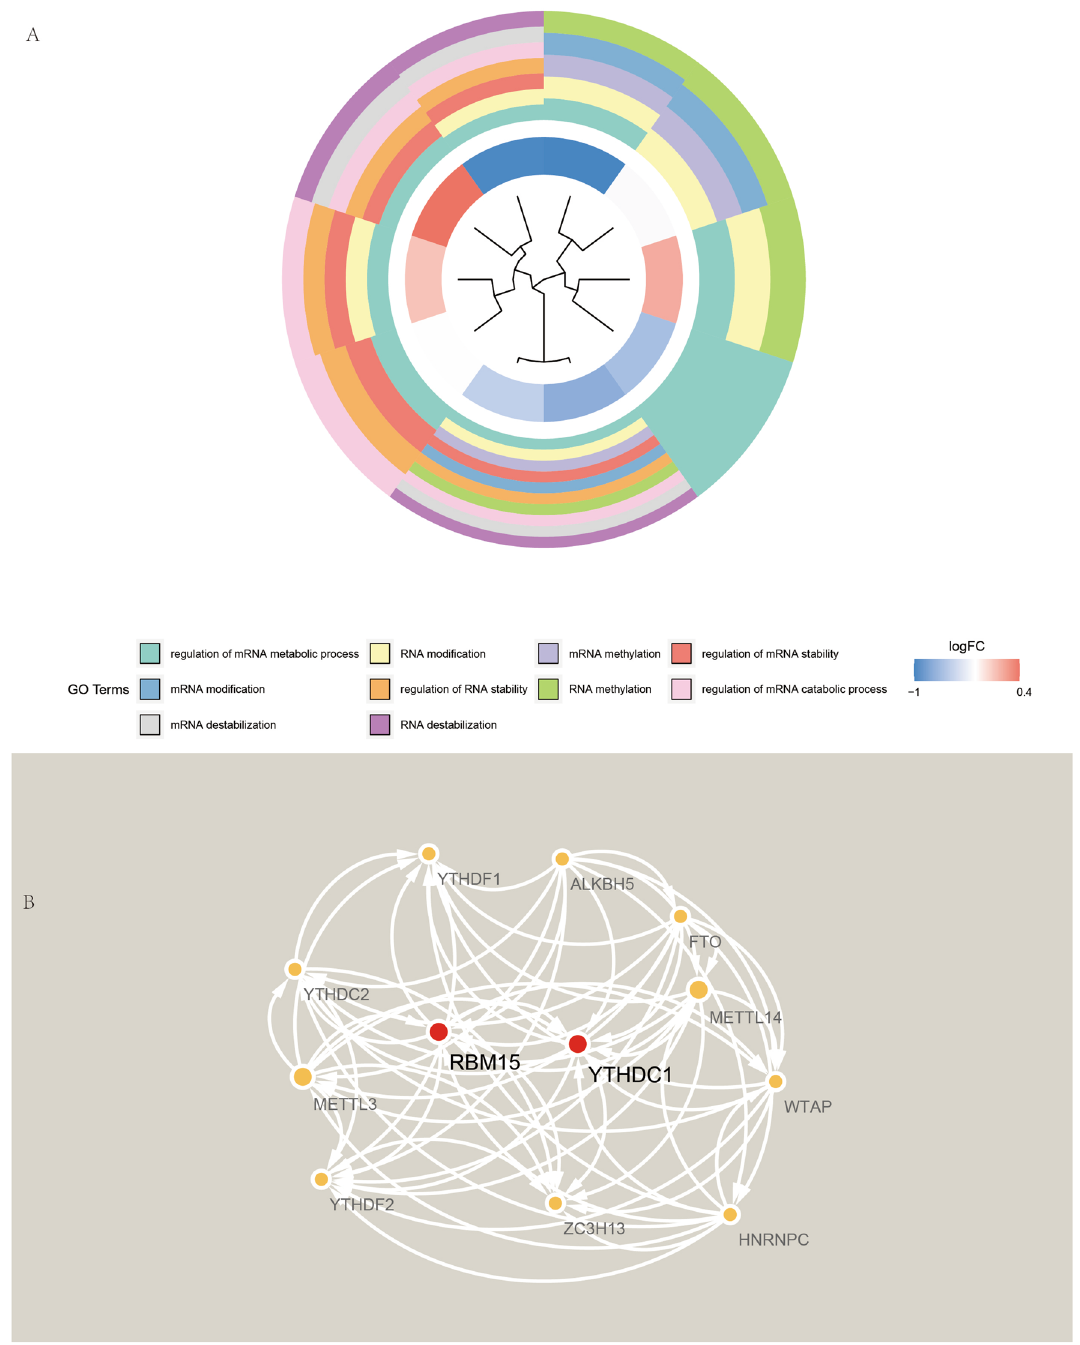
Figure 3. GO enrichment analysis and protein–protein interaction network diagram. ( A ) Shows the GO enrichment analysis of m6A-associated genes. ( B ) Shows the protein–protein interaction network of m6A- related